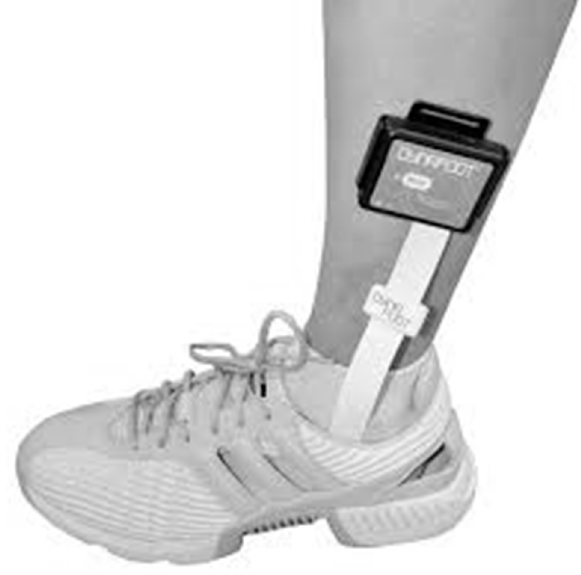
Figure 2. Foot pressure analysis system.